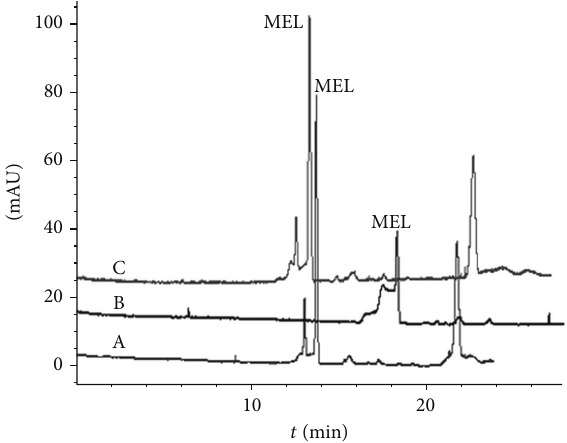
Figure5:Electropherogramsofrealsamplewith/withouttheNaOH flushing step. (A) The first run of real sample with NaOH rinsing step; (B) the second run without NaOH rinsing step; and (C) the third run with NaOH re-rinsing. Condition: see Figure 3.